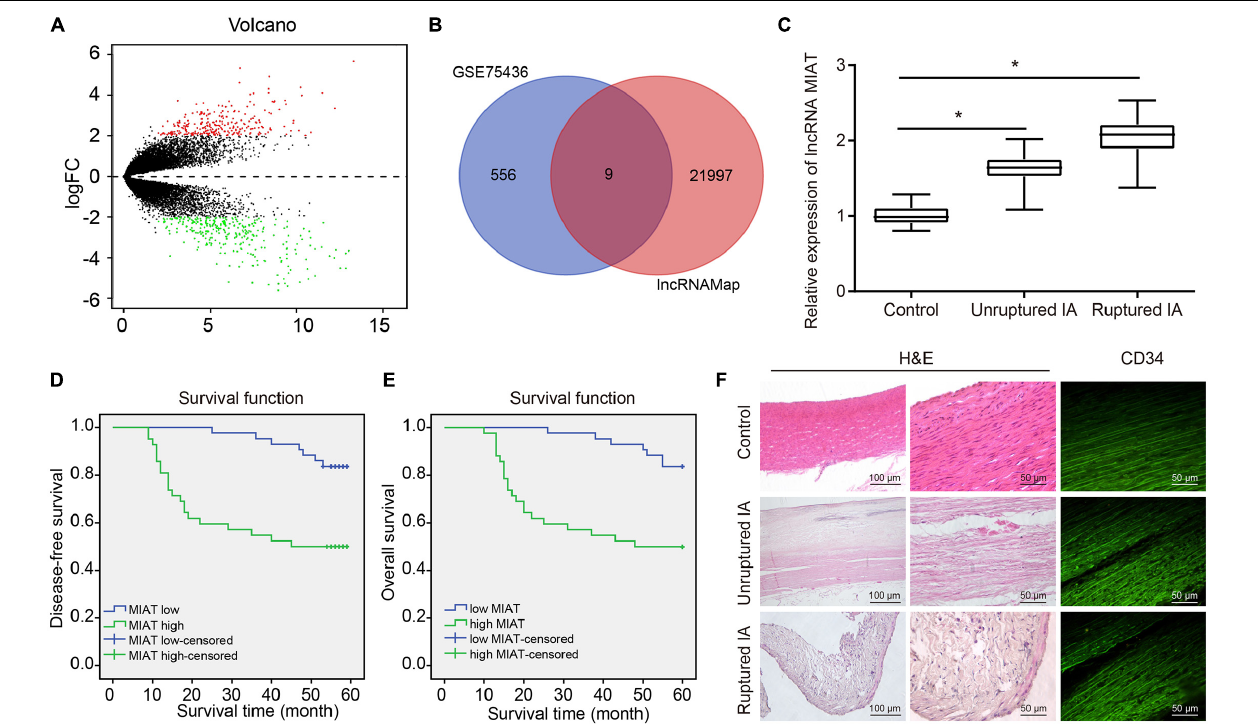
FIGURE 1 | The high expression of MIAT and damaged endothelial cell continuity are observed in patients with IA. (A) The volcano plot of GSE75436 analyzed by R language. Red dots represented the upregulated genes, and green dots represented the downregulated genes (LogFC > 2, p < 0.01). (B) The Venn diagram of the differentially expressed lncRNAs in GSE75436 and the total lncRNAs obtained from lncMAP, and the intersections included lncRNA SFTA1P, CTD-2165H16.3, NAPSB, RP3-525N10.2, CTB-12O2.1, FLVCR2, EMX2OS, EGFEM1P, and MIAT. (C) The expression of MIAT in ruptured IA, unruptured IA, and control samples determined by RT-qPCR. (D) The correlation between the expression of MIAT and disease-free survival of patients with IA. (E) The correlation between the expression of MIAT and overall survival of patients with IA. (F) The HE staining ( × 100, × 200) for carotid arteries near branch or IA lesions, and immunofluorescence staining ( × 200) for vascular endothelial cells labeled with CD34 antibody. * p < 0.05 vs. the control samples. The measurement data were expressed as mean ± standard derivation. Comparisons between two groups were analyzed by unpaired t test, while the correlation between the expression of MIAT in patients with IA and their disease-free survival and overall survival was analyzed by Kaplan–Meier method (long-rank test).